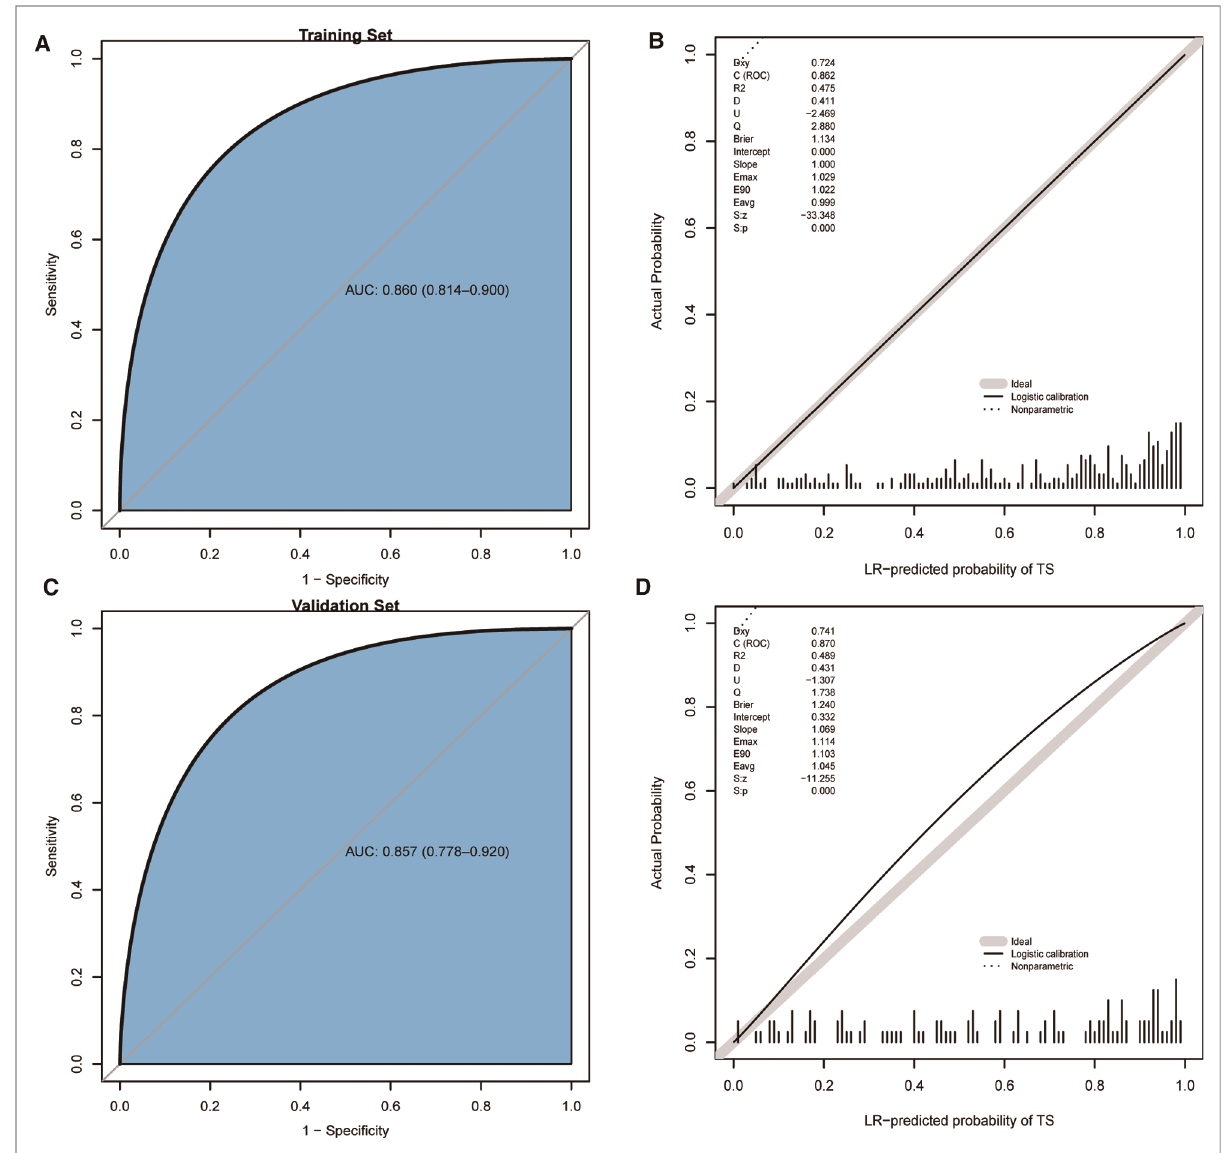
FIGURE 5 ROC curves and calibration curves of the training set, validation set, and scoring system. ( A ) ROC curve of the training set. ( B ) Calibration curve of the training set. ( C ) ROC curve of the validation set. ( D ) Calibration curve of the validation set. ROC, receiver operating